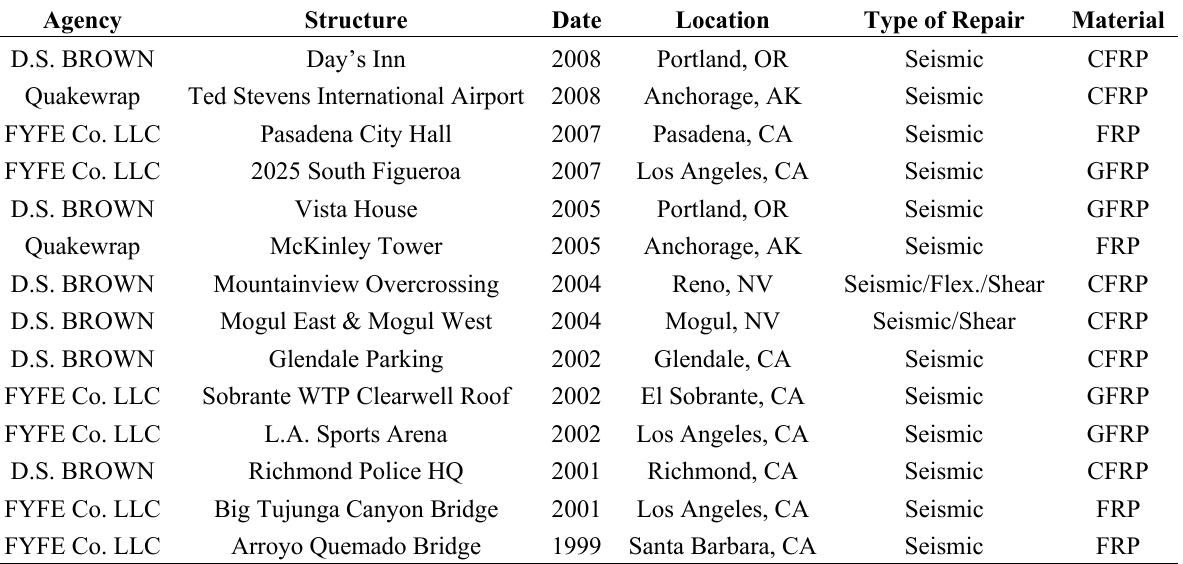
Table 5. Selected field application projects: columns retrofitted for seismic loads.